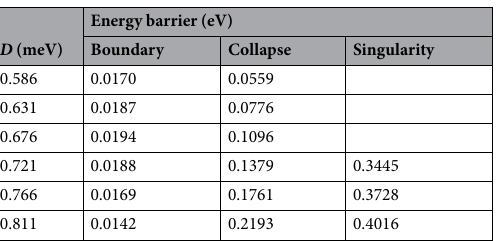
Table 1. Energy barriers for the skyrmion destruction energy paths. Energy values are computed with respect to the skyrmion energy for different DMI constants. The singularity driven skyrmion destruction is only observed for strong enough DMI constant